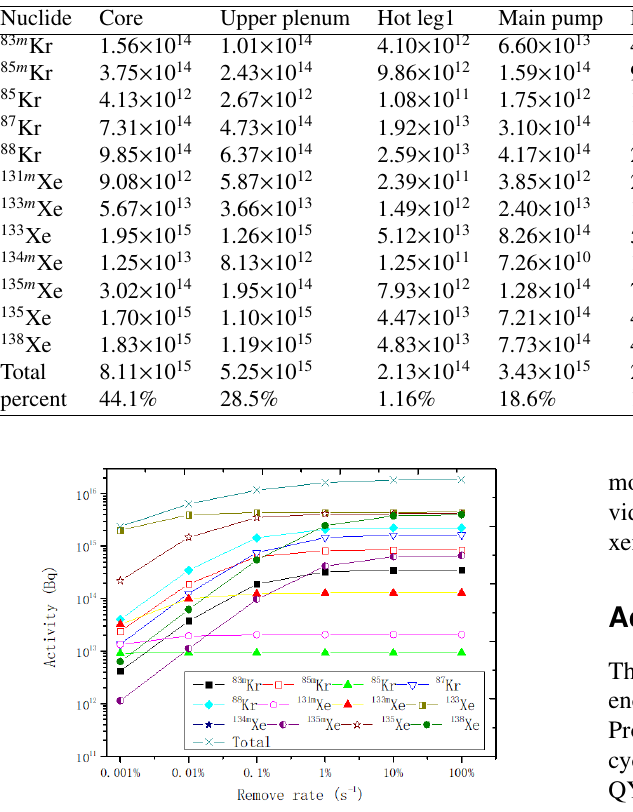
Figure 8. Krypton and xenon in o ff gas system with removal